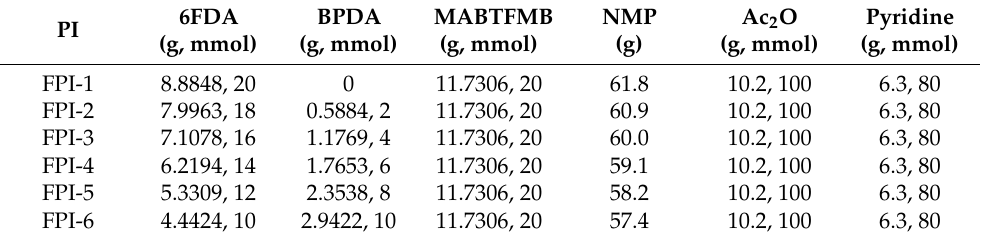
Table 1. Formula for the FPI